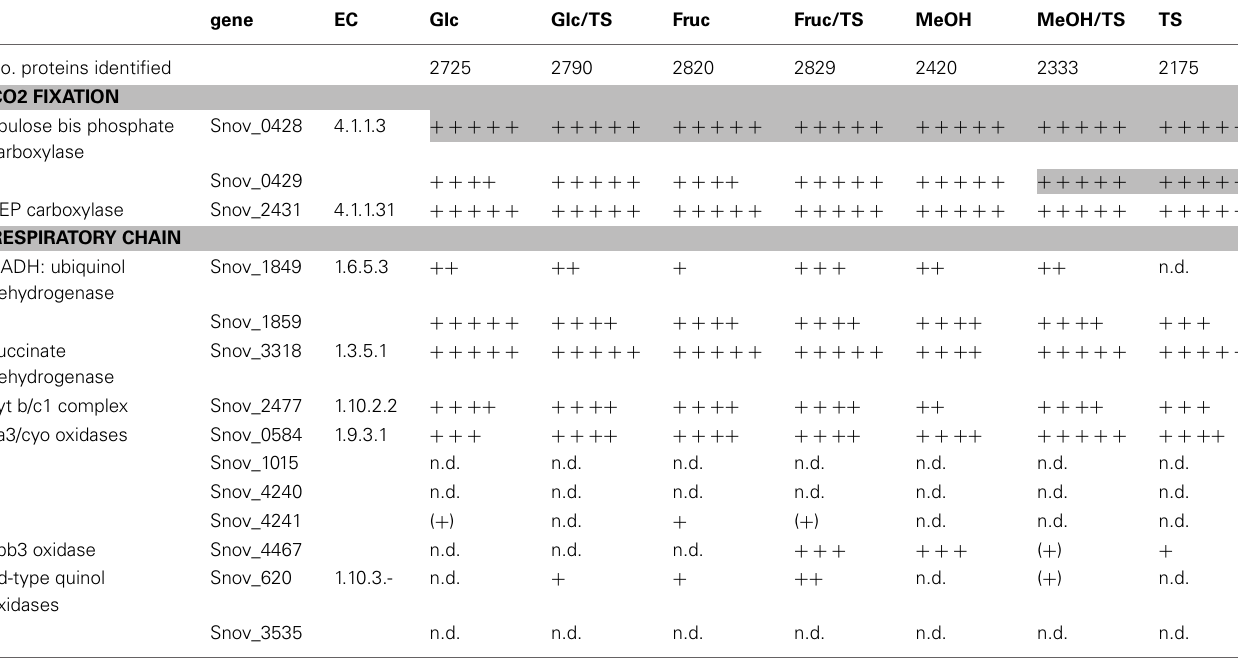
Table 1 | Presence of proteins involved in carbon dioxide fixation and respiration in S. novella cell extracts from chemolithoautotrophic, methylotrophic, heterotrophic, and mixotrophic growth